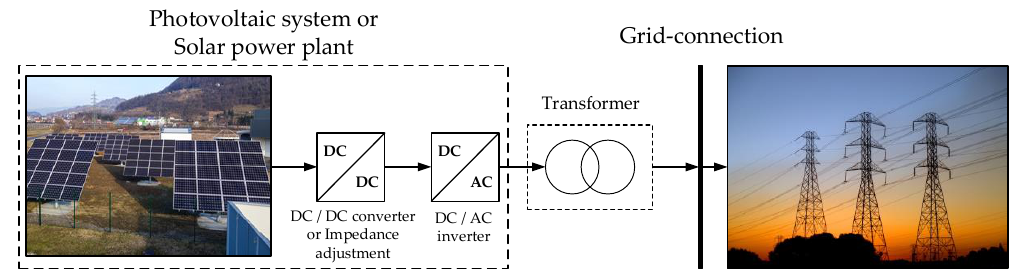
Figure 2. Basic connection of the grid-connected photovoltaic (PV) system.